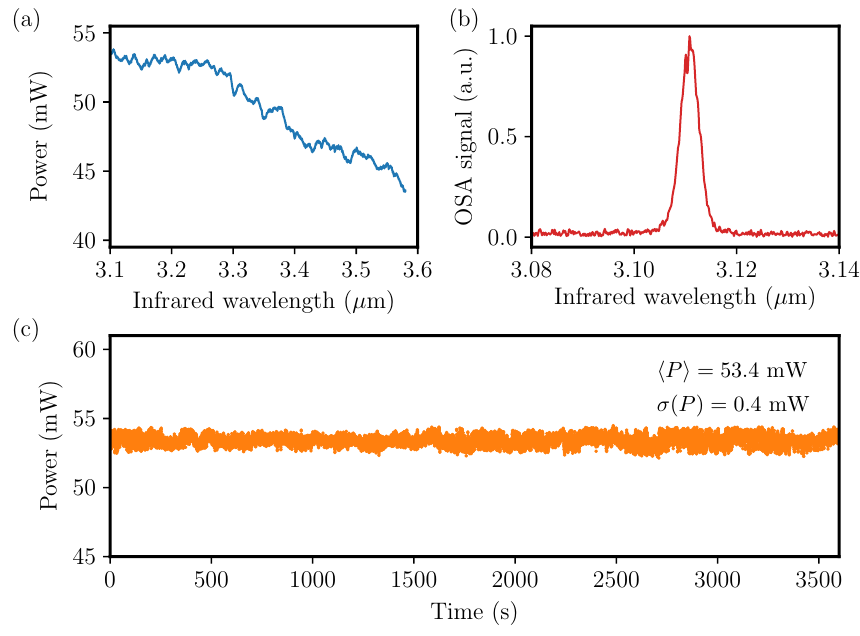
Figure 3. MIR-OPO performance characterization. ( a ) Average output power curve versus wavelength. ( b ) Example pulse spectrum measured at 3.11 µ m. ( c ) Power-stability measurement at a fixed wavelength of 3.11 µ m over a duration of 1